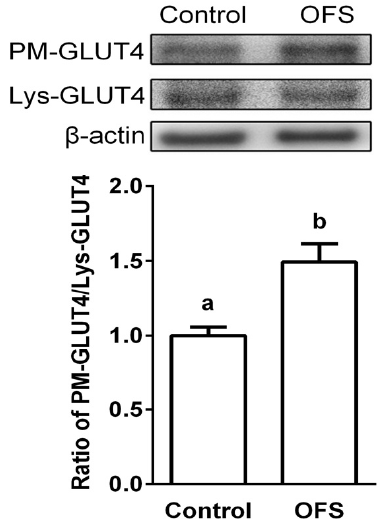
Figure 4. Effects of OFS on GLUT4 translocation to the plasma membrane in L6 myoblasts. Cells were treated with OFS, and total cell lysates (Lys) and plasma membrane fraction (PM) were analyzed by west blotting. Each value is the mean ± SE ( n = 3). The bars with a different letter are significantly different from each other at the level of p < 0.05.